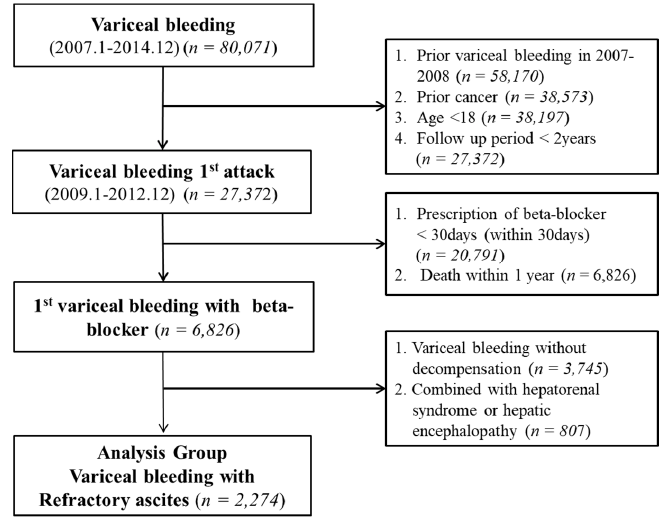
Figure 1. Flowchart. Figure 1.